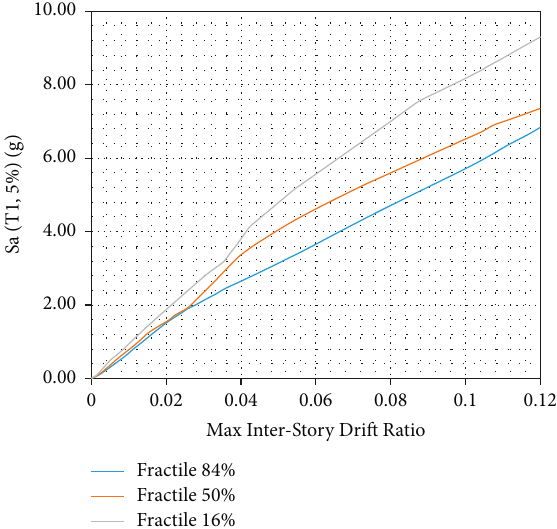
Figure 24: Fractile curves of the TS-BRB braced portal frame.